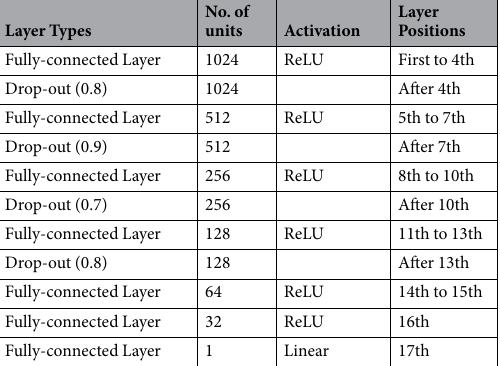
Table 3. ElemNet Architecture. Considering the Input as the 0th layer, types and positions of different types of fully connected and dropouts are shown below. Dropout layers are used to prevent overfitting and they are not counted as a separate layer. We used ReLU as the activation